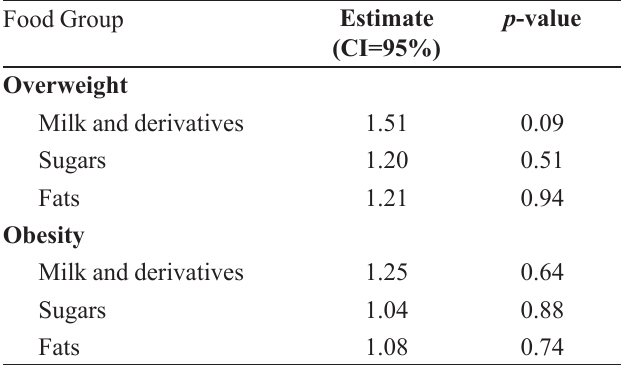
TABLE III - Relationship between excessive consumption of food and overweight and